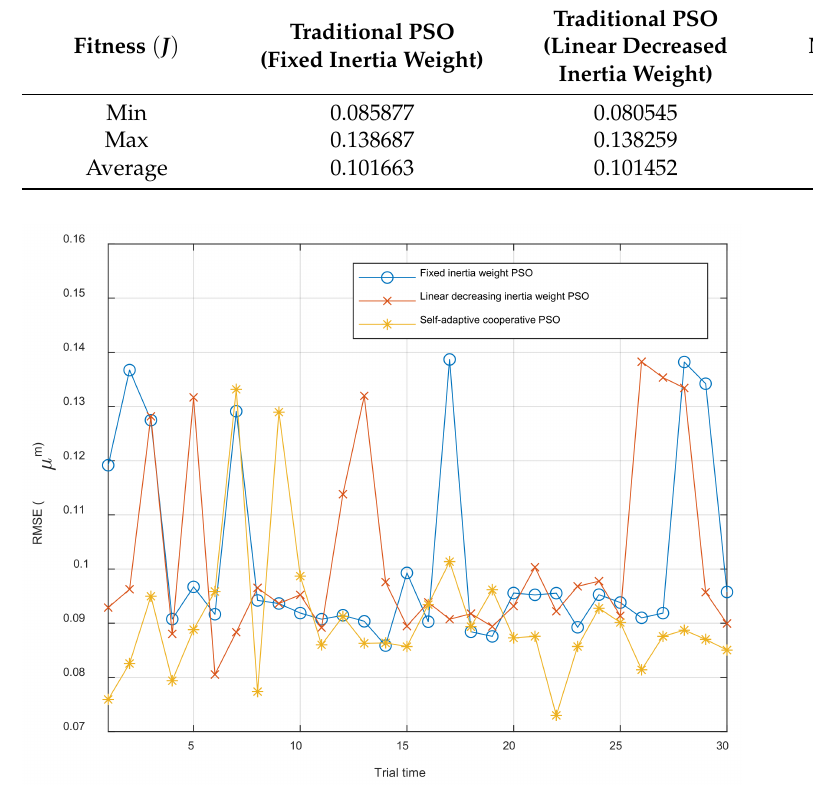
Figure 10. Convergence process of different algorithms. Table 6. Performance of different algorithms in repeat experiments.